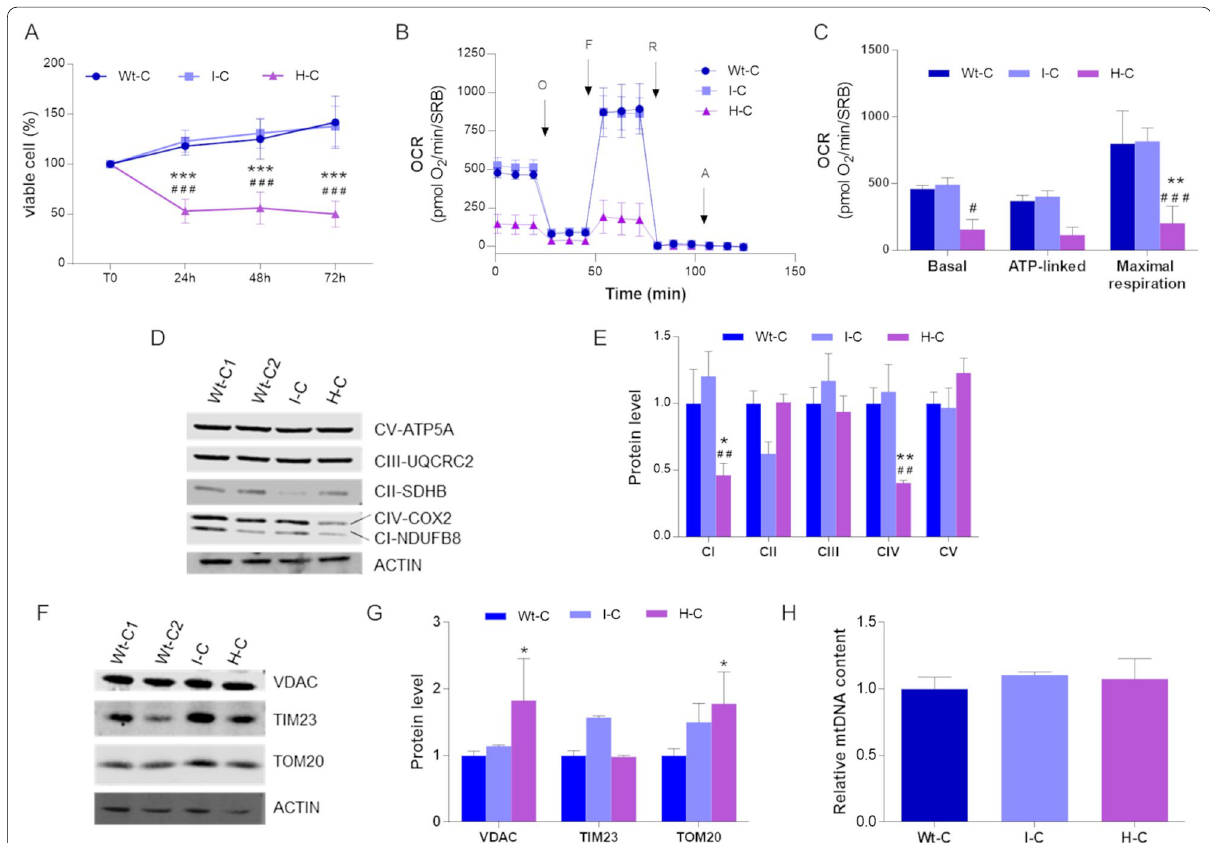
Fig. 1 Bioenergetics assessment in MERRF cybrids. A Cell viability was evaluated growing cells for 24 h, 48 h and 72 h in galactose-medium and by performing SRB assay. Data are means SEM of four independent experiments (biological replicates). B OCR expressed as pmoles O 2 /min, ± normalized for protein content, under basal conditions and after injection of oligomycin (O), carbonyl cianide 4-(trifluoromethoxy) phenylhydrazone (FCCP; F), rotenone (R) and antimycin A (AA). Data are expressed as means SEM of three independent experiments (biological replicates). C Basal, ± ATP-linked and maximal respiration. All values are means and SEM of three independent experiments (biological replicates). D Western blot of OXPHOS subunits; ACTIN was used as loading control. A representative blot of three independent experiments, analyzing three biological replicates, is shown for each protein. E Densitometry of OXPHOS subunits of three independent experiments (biological replicates). All data are means and SEM and are normalized to control cells. F Western blot of VDAC, TIM23 and TOM20; ACTIN was used as loading control. A representative blot of three independent experiments (biological replicates) is shown for each protein. G Densitometry of VDAC, TIM23 and TOM20 content. All data are means and SEM and are normalized to control cells. H mtDNA content evaluation by qPCR. All values are expressed as means and SEM of three biological replicates and are normalized to control cells. Statistical analyses were performed with ANOVA test (Tukey’s multiple comparisons test). *, ** and *** values significantly different from the control cells, p < 0.05, p < 0.01, p < 0.001 respectively; # , ## and ### values significantly different from the I-mutant, p < 0.05, p < 0.01, p < 0.001, respectively. Wt-C wild type cybrids, I-C intermediate heteroplasmy cybrids, H-C high heteroplasmy